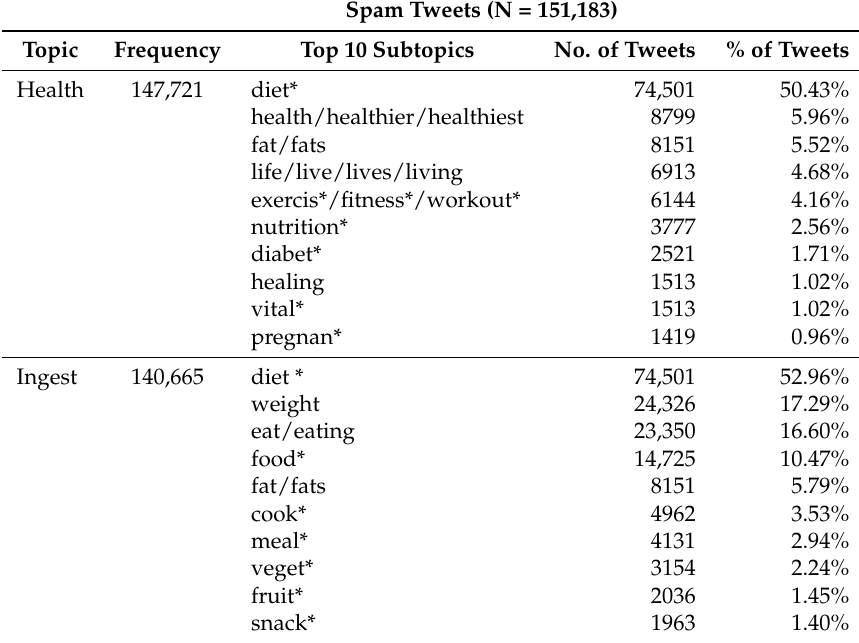
Table 7. Summary of Prominent Sub-topics in Tweets by Spam